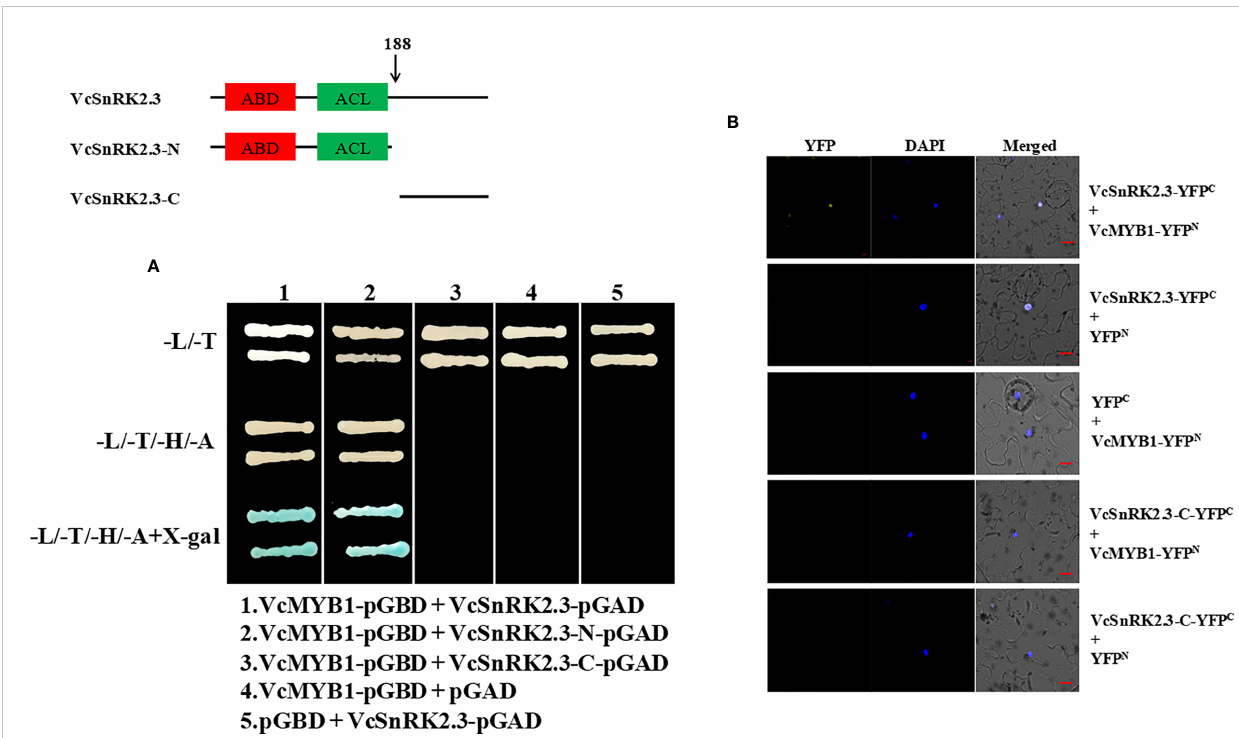
FIGURE 6 VcSnRK2.3 interacts with VcMYB1. (A) Yeast two-hybrid assays. The N-terminus of VcSnRK2.3 interacts speci fi cally with VcMYB1. Yeast grown in SD-Leu/-Trp (-L/-T) medium, SD-Leu/-Trp/-His/-Ade (-L/-T/-H/-A) medium or SD-Trp/-Leu/-His/-Ade supplemented with X-gal (-T/-L/-H/-A+X- gal) medium. (B) Bimolecular fl uorescence complementation assays. The open reading frames of VcSnRK2.3 and VcMYB1 were fused to the C-terminus part of YFP and the N-terminus part of YFP. Scale bar = 10 µm. A representative image was presented after this experiment was carried out three times with similar